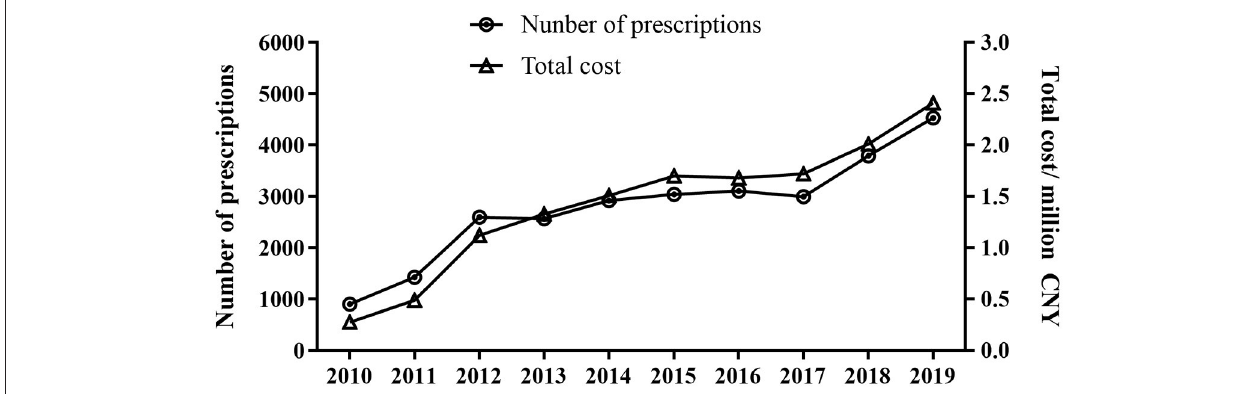
FIGURE 1 | Total trends of prescriptions and expenditure of ADHD drugs from 2010 to 2019.